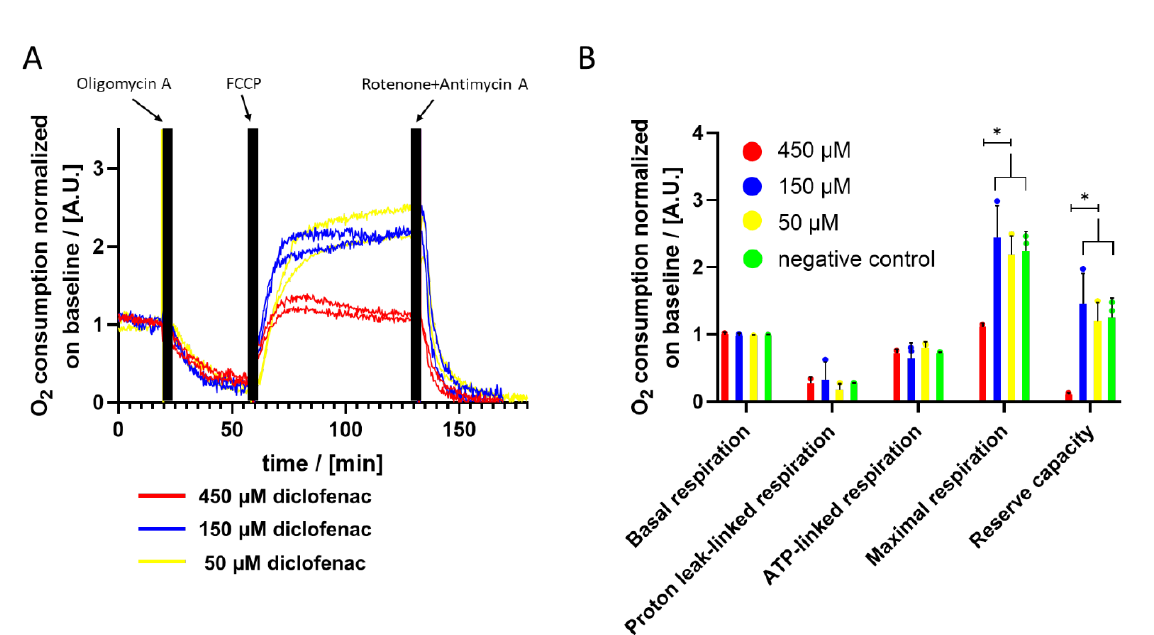
Figure 6: Analysis of the influence of the treatment with different concentrations of diclofenac for 24 hours. A ) OC after subsequent application of oligomycin A, FCCP and R/A of PHH pretreated with diclofenac. B ) Detailed analysis of cellular respiration of PHH treated with different concentrations of diclofenac (n=2 for 450 µM diclofenac; n=3 for 150 µM and 50 µM diclofenac; significance: * equals p- values <